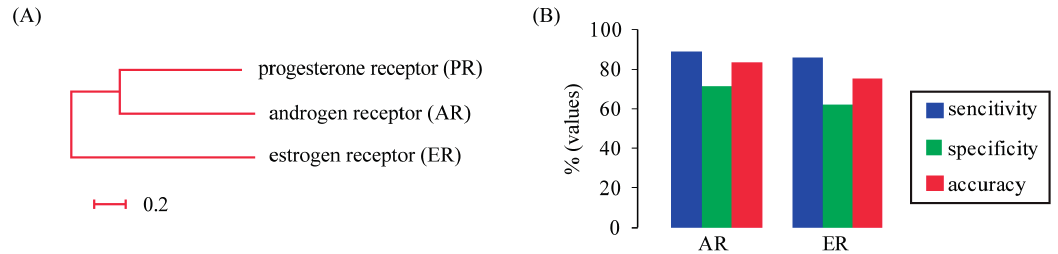
Figure 2. The performance of SVM classifier on different test sets. ( A ) The close homology between progesterone receptor (PR), androgen receptor (AR) and estrogen receptor (ER). The phylogenetic tree was constructed using maximum-likelihood method based on human protein sequences. The scale bar below the tree indicates amino acid change frequency;